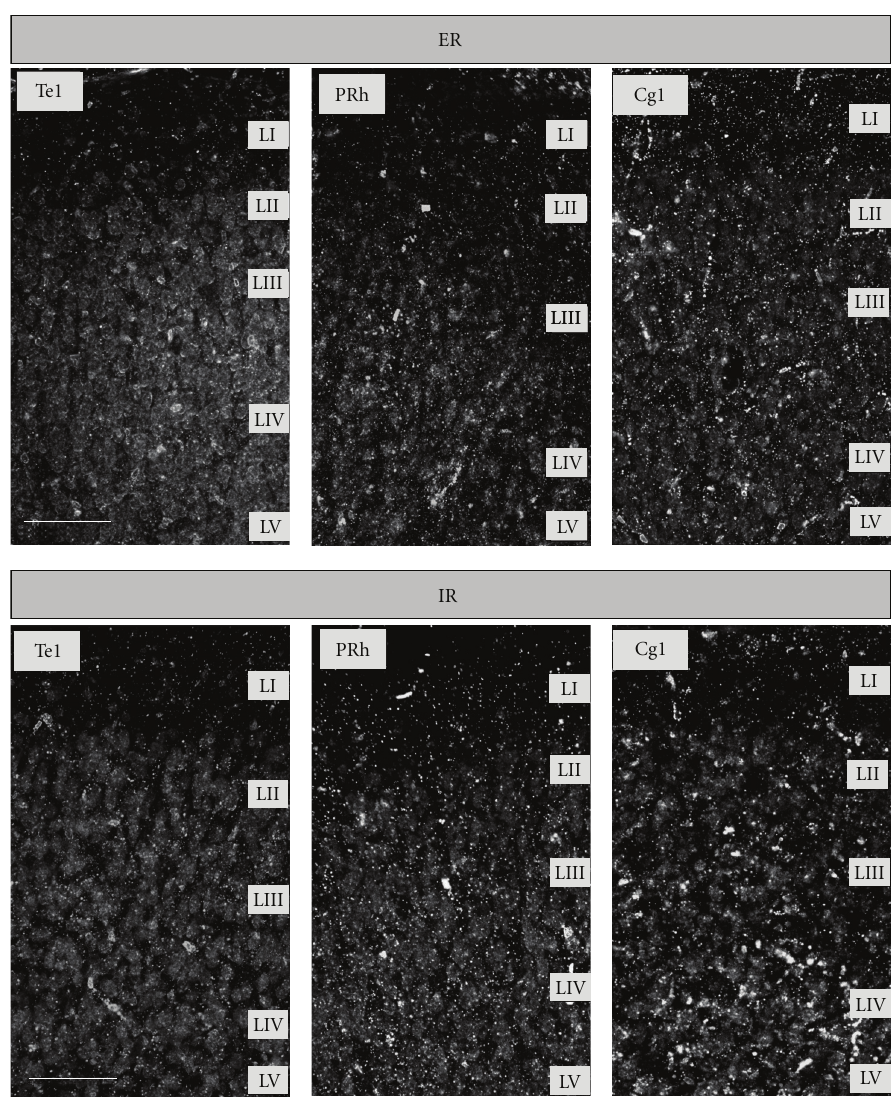
Figure 3: Top panel. Degrading axon terminals as indicated by silver-stained granules (light intensities) after Gallyas et al. (1980) [32] throughout primary sensory (Te1) and limbic areas (PRh and Cg1) of an enriched-reared gerbil (dark field at 200x magnification). Bottom panel. Congruent sections of the respective cortical areas of an impoverished-reared gerbil. Scale bar = 100 µ m.